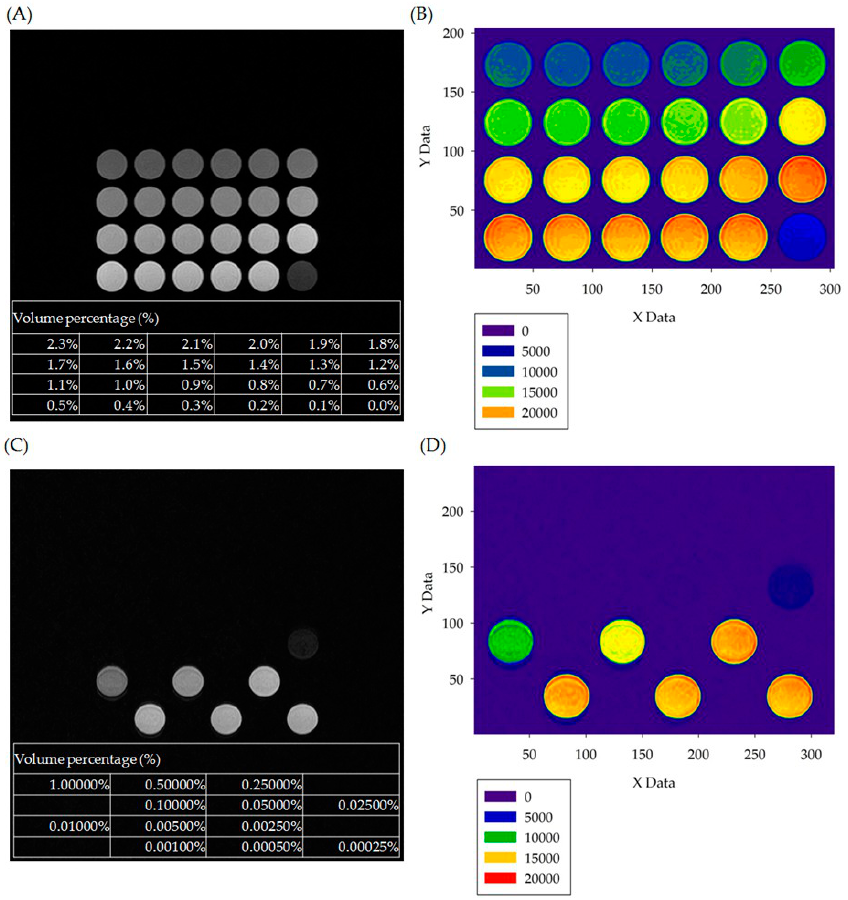
Figure 2. ( A ) T1W pulse sequence imaging with samples of paramagnetic contrast agent of Gd-DTPA-BMEA diluted to different volume percentages (%). ( B ) Color layer images of MRI imaging in the visualized grayscale numerical statistics; the lower left corner of the figure is the grayscale value color distribution table of each figure. ( C ) T2W pulse sequence imaging with samples of superparamagnetic contrast agent of ferucarbotran diluted to different volume percentages. ( D ) Color layer images of MR imaging in the visualized grayscale numerical statistics; the lower left corner of the figure is the grayscale value color distribution table of each figure.